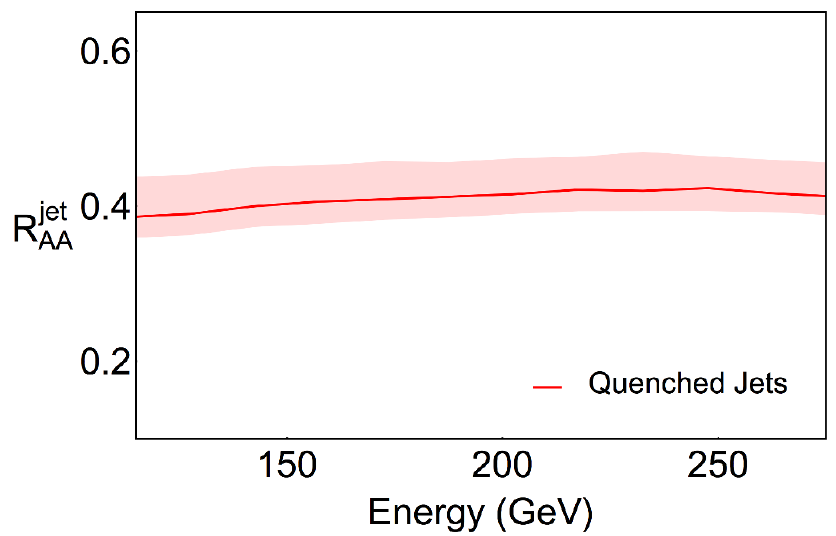
Figure 9 . Jet suppression R jet , the ratio of the number of jets with a given energy in our ensemble AA after the jets have been quenched via passage through the expanding cooling droplet of plasma to the number of jets with the same energy in the initial ensemble, before quenching. As in (cid:12)gure 8, the pink band shows the results obtained from our ensemble of strings for a range in the parameter a given by a = 1 : 8 (cid:0) 2 : 5, with a = 2 shown in dark red. We have chosen the value of b , the second free parameter in the model, de(cid:12)ned in the text, to be b = 0 : 21 so as to obtain a jet